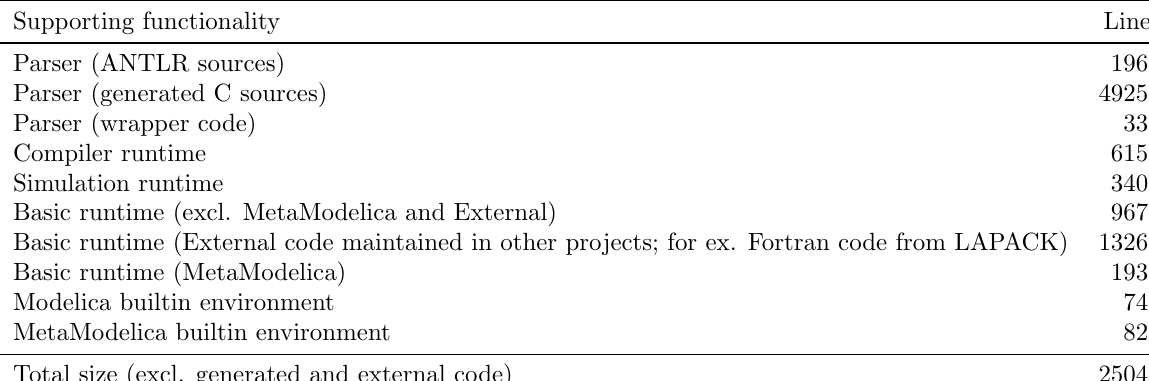
Table 2: Sizes of OMC Parser and